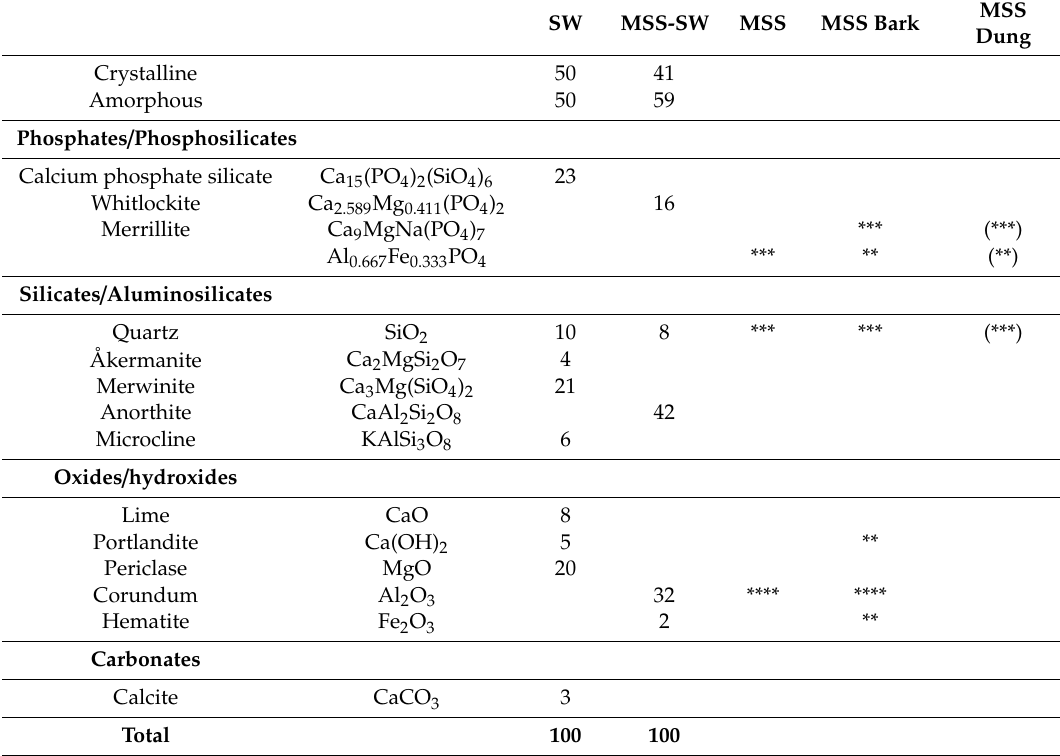
Table 9. Semi-quantitative analysis results from XRD. The industrial-scale samples provided enough sample amounts for a more reliable